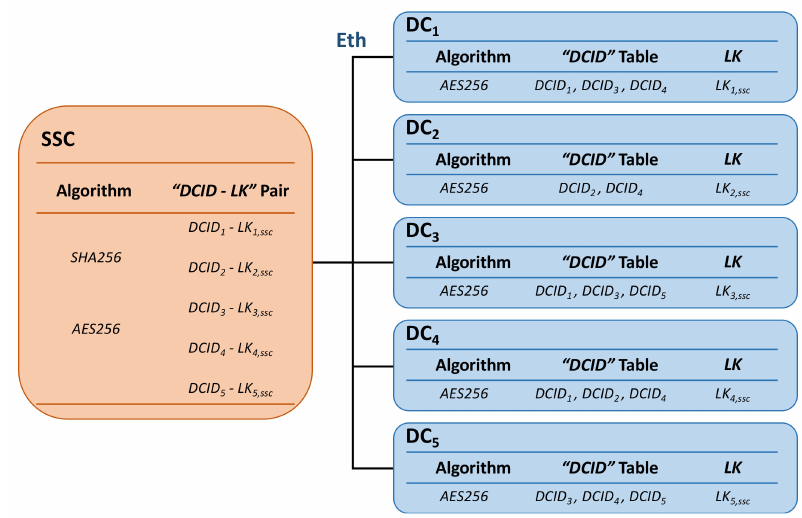
Figure 4. Initialization phase and registration